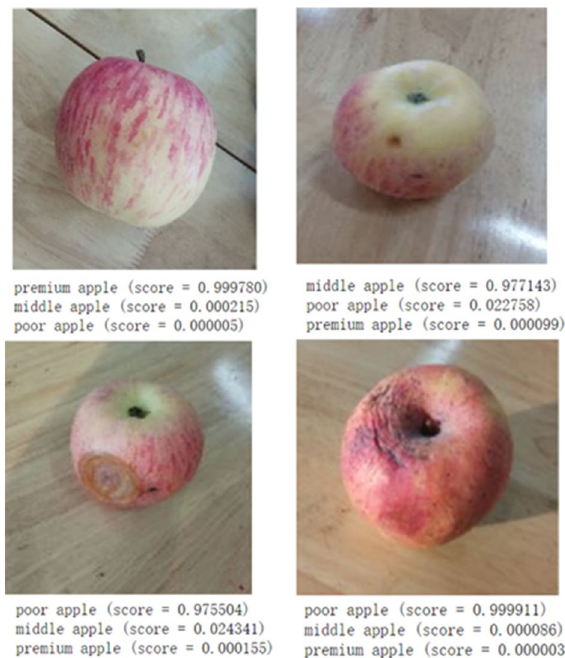
Figure 14. A few of prediction results for independent testing dataset.